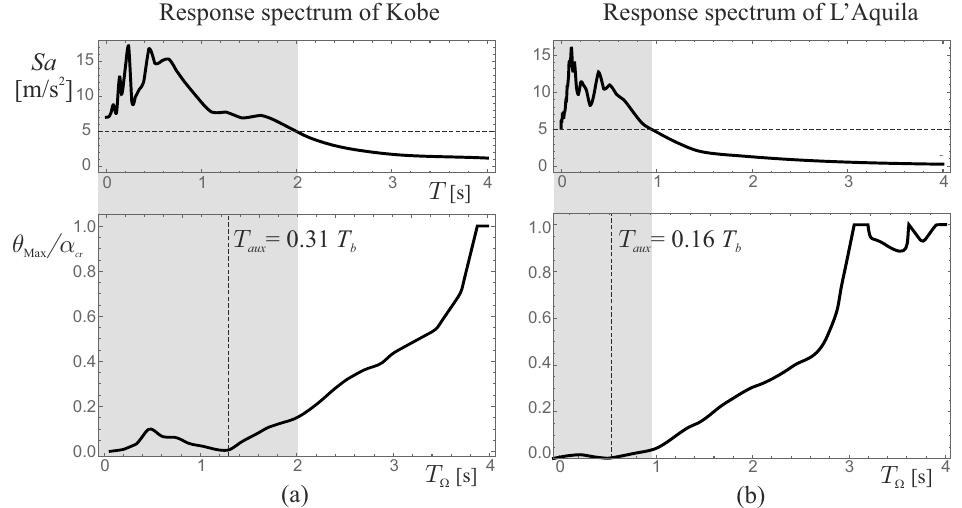
Figure 12. Comparison between the response spectrum of the seismic records (upper graphs) and the frequency–response curves of coupled systems with rigid blocks of dimensions 2 b = 1.2 m and λ = 6 (lower graph): ( a ) Kobe seismic record; ( b ) L’Aquila seismic record ( r = 0.9595, m = 0.05 M , u y = 1/3 u cr , ψ =